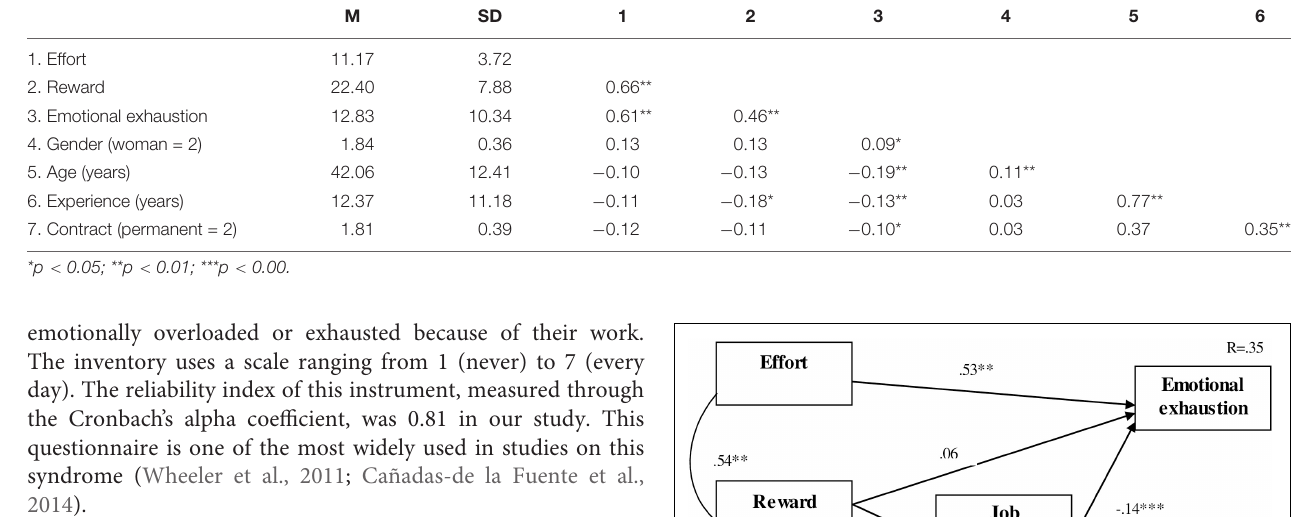
TABLE 1 | Means, standard deviations, and correlations of variables in the model. M SD 1 2